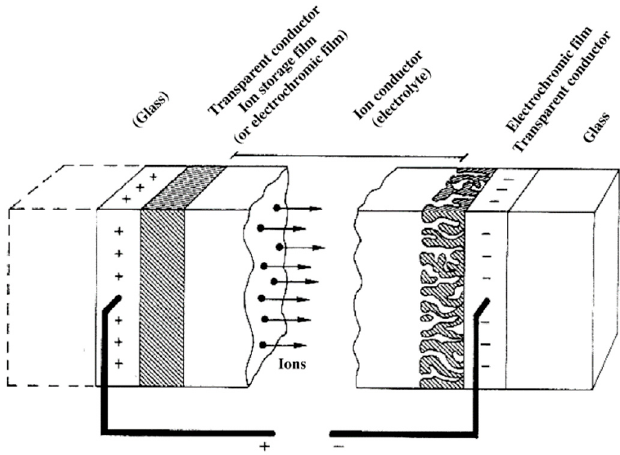
Figure 1. Basic design of an electrochromic device, showing transport of positive ions under the action of an electric field. Reprinted with permission from Elsevier Ltd. [13].